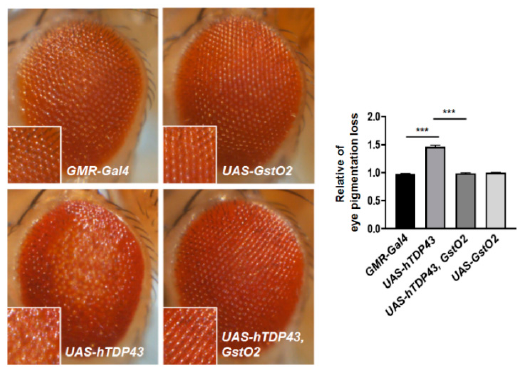
Figure 1. The expression of glutathione S-transferase omega 2 (GstO2) resulted in alterations of human transactive response DNA-binding protein-43 (hTDP-43)-induced retinal degeneration. Magnified images show pigment loss of each genotype. The external eye phenotypes of GMR-Gal4 control flies and flies expressing GstO2 alone were normal. The overexpression of hTDP-43 with the GMR-Gal4 driver induced a rough eye phenotype, including the consistent loss of eye pigmentation. The degeneration of the external eye phenotype was rescued by the co-expression of hTDP-43 with GstO2. Quantification of pigment loss in the selected area (magnified view) for each genotype was performed by ImageJ software and normalized to the value of the GMR-Gal4 control flies. Statistical significance was determined using the unpaired Student t -test (*** p < 0.001, n = 10 for each genotypes). Error bars indicate the standard error of the mean